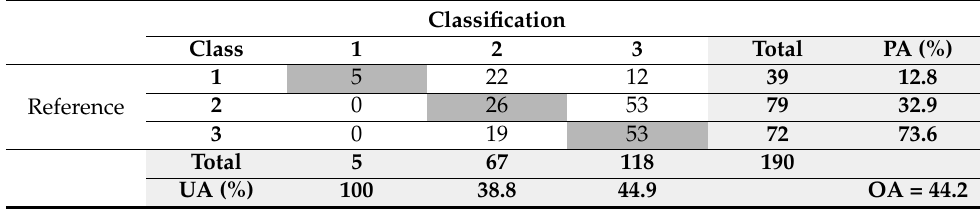
Table 2. Confusion matrix of EBA for NoL calculation, with GEDI input data (UA = user accuracy; PA = producer accuracy; OA = overall accuracy).